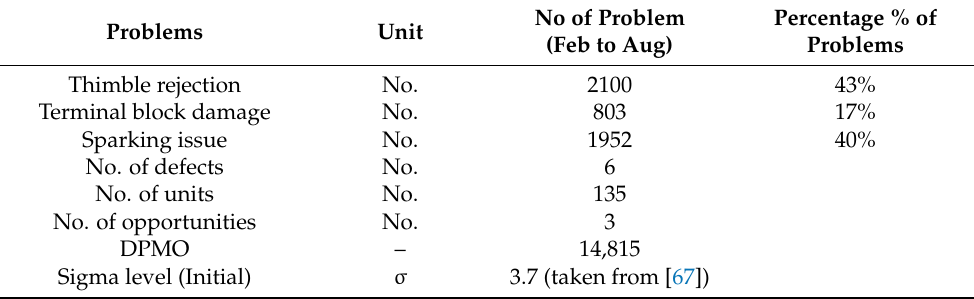
Table 5. Summary of expanding machine data (Before LLS improvement).